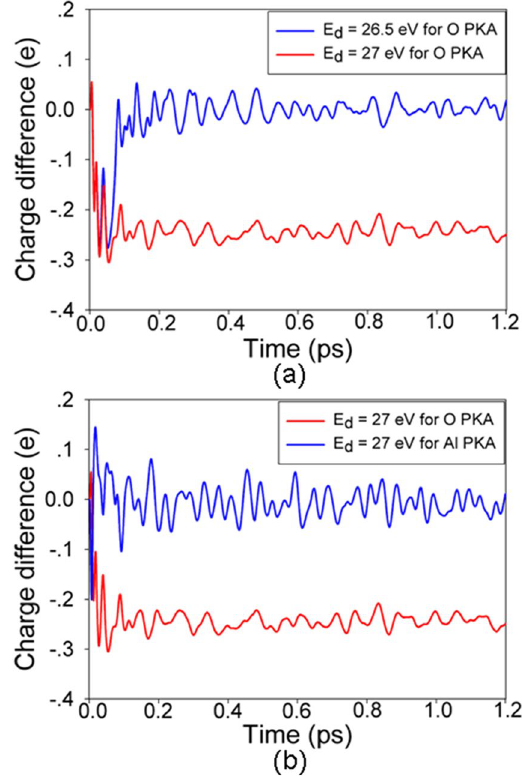
Figure 1. Charge difference for ( a ) O [2110] PKA at energies of 26.5 and 27 eV; ( b ) O and Al PKAs along the [1120] direction at the energy of 27 eV.